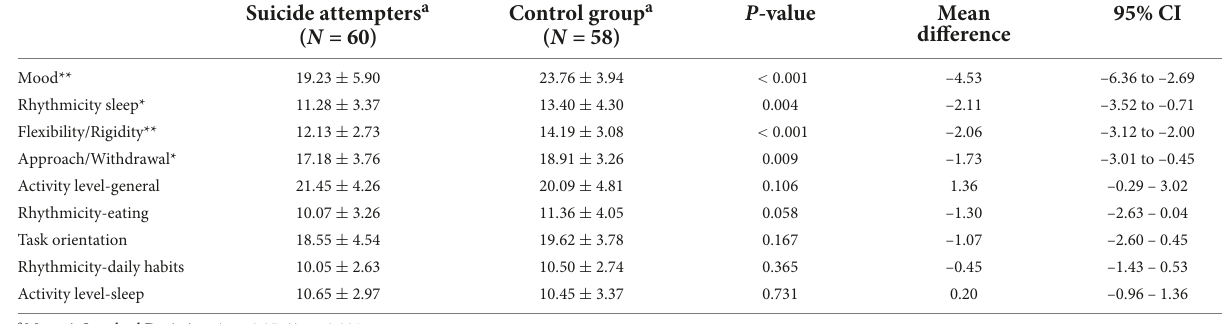
TABLE 4 Comparison of temperament characteristics between suicide attempters and control group.